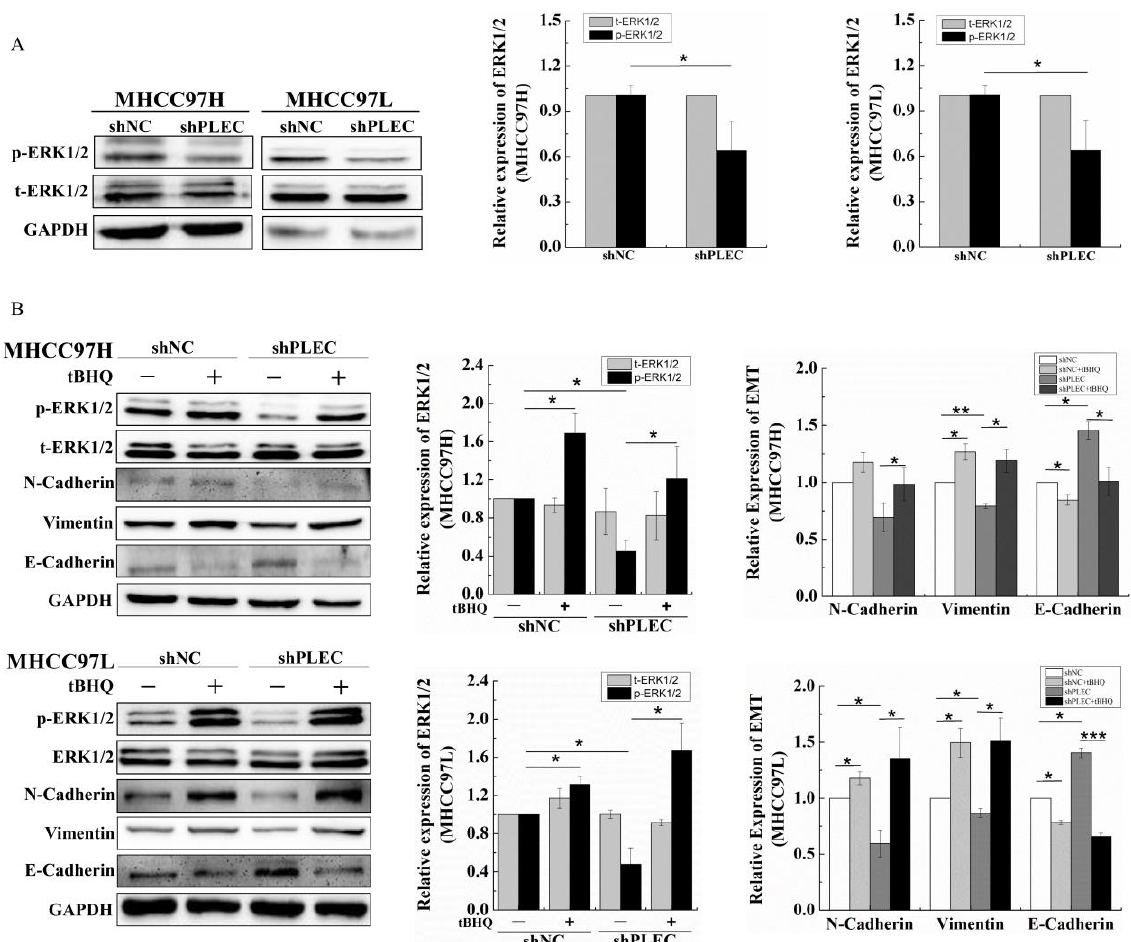
Figure 3. Activation of ERK1/2 recovered the plectin downregulation-inhibited EMT of HCC cells. ( A ) Western blot detection of p-ERK1/2 and t-ERK1/2 protein expression in cells transfected with shNC and shPLEC and quantification data of Western blot detection of p-ERK1/2 and t-ERK1/2 protein levels in cells transfected with the shNC and shPLEC. ( B ) Western blot detection of the p- ERK1/2, t-ERK1/2, N-cadherin, vimentin and E-cadherin protein levels after tBHQ treatment in cells transfected with shNC and shPLEC and quantification data of Western blot detection of p-ERK1/2, t-ERK1/2, N-cadherin, vimentin and E-cadherin protein levels after tBHQ treatment in cells transfected with shNC and shPLEC. p-ERK1/2: phosphorylation of extracellular regulated protein kinases 1/2; t-ERK1/2: total extracellular regulated protein kinases 1/2; tBHQ: tert-butylhydroquinone; GAPDH: glyceraldehyde-3-phosphate dehydrogenase. Data are presented as mean with SD; n = 3, * p < 0.05; ** p < 0.01; *** p < 0.001.